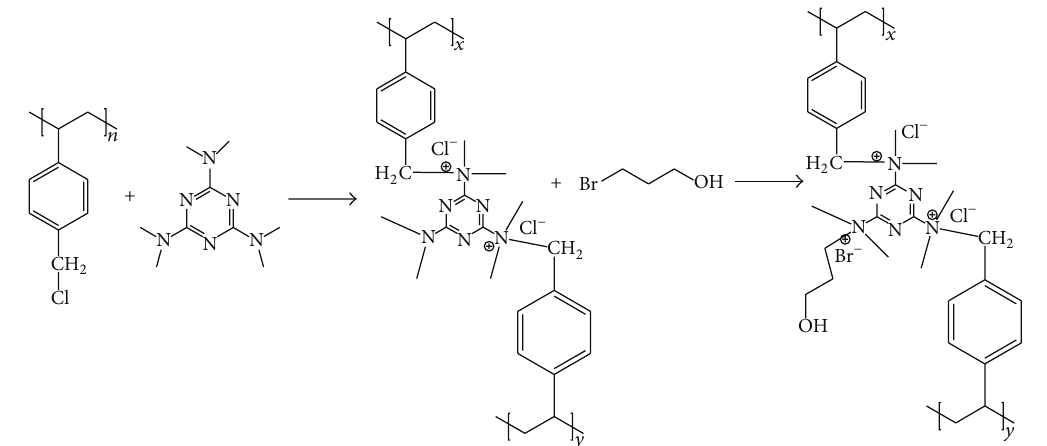
Figure 1: Synthesis and structure of polymer biocide which contains quaternary ammonium salts (QAS) groups.